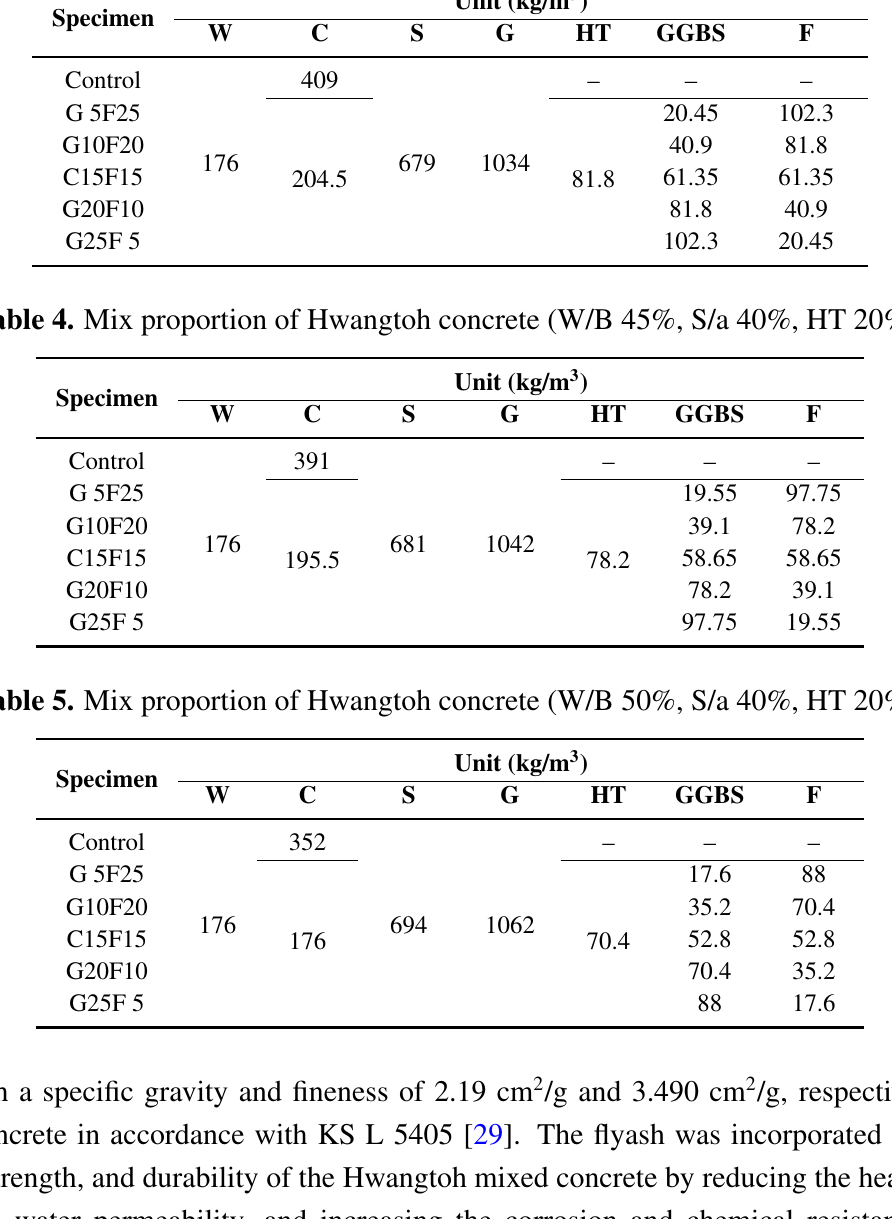
Table 3. Mix proportion of Hwangtoh concrete (W/B 43%, S/a 40%, HT 20%). Specimen